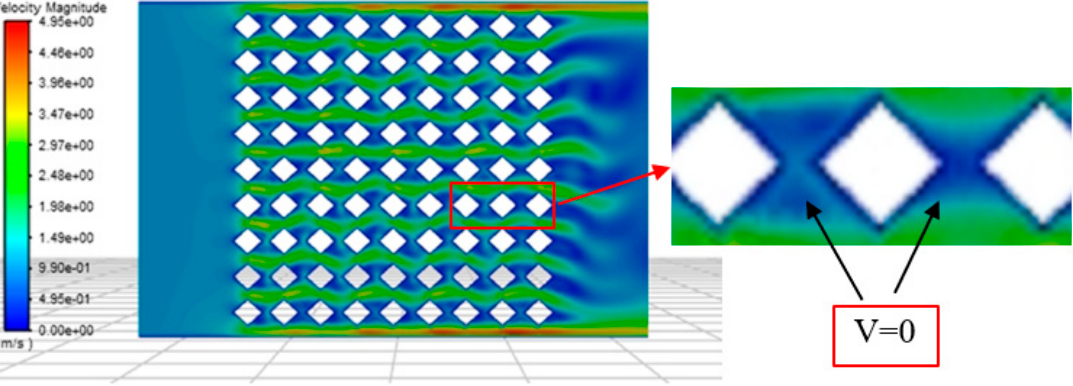
Figure 8. Flow velocity cloud of pin-finned microchannel.